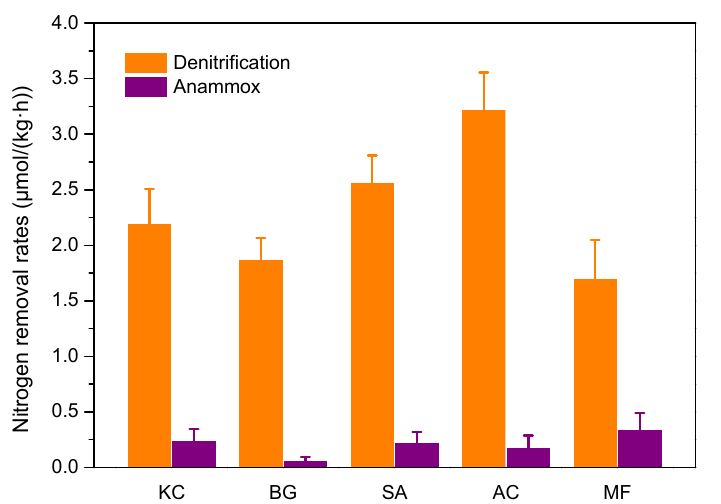
Figure 3. Denitrification and anammox rates at the sampling sites. KC, BG, SA, AC, and MF are site abbreviations for Kandelia candel , Bruguiear gymnorrhiza , Sonneratia apetala , Aegiceras corniculatum , and mud flats, respectively.